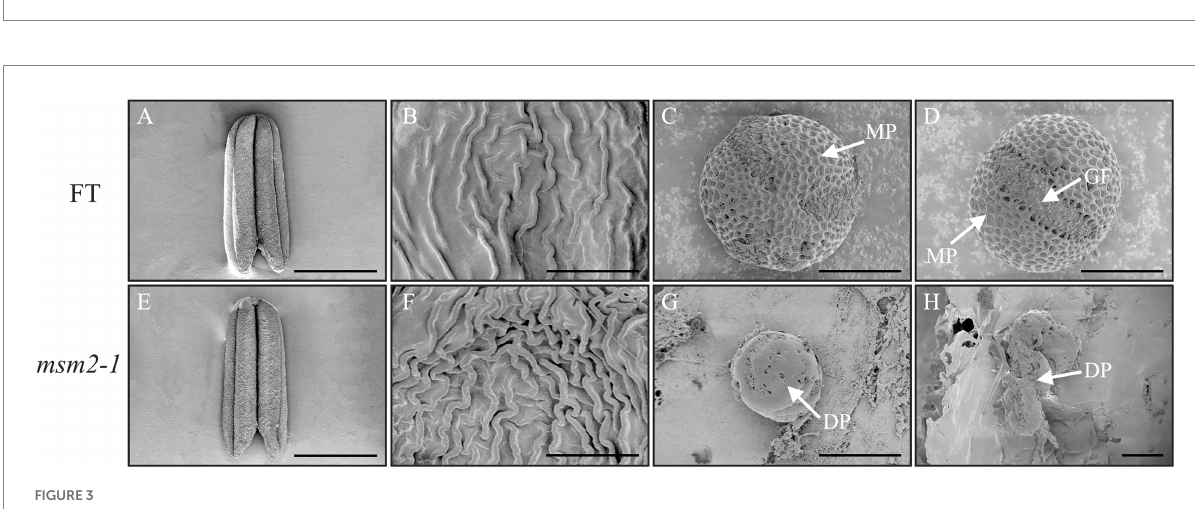
FIGURE 2 Anther paraffin section observation of the wild-type “FT” and msm2-1/2/3 mutants. (A–D) The stage of tapetal formation (i.e., the tetrad period), BUD1 < 1.5 mm; (E–H) The stage of the tapetum cell structure integrity and clearly demarcated (i.e., the uninucleate microspore stage), BUD2: 1.5–2.0 mm; (I–L) The stage of tapetal cytoplasm dense, BUD3: 2.0–2.5 mm; (M–P) The stage of tapetum cells begin the degradation, BUD4: 2.5–3.0 mm; (Q–T) The stage of tapetum cells complete the degradation, BUD5: 3.0–3.5 mm; (U–X) The stage of anthers dehiscence and mature pollen release, BUD6 > 3.5 mm. T tapetum. Scale bar, 50 μm .